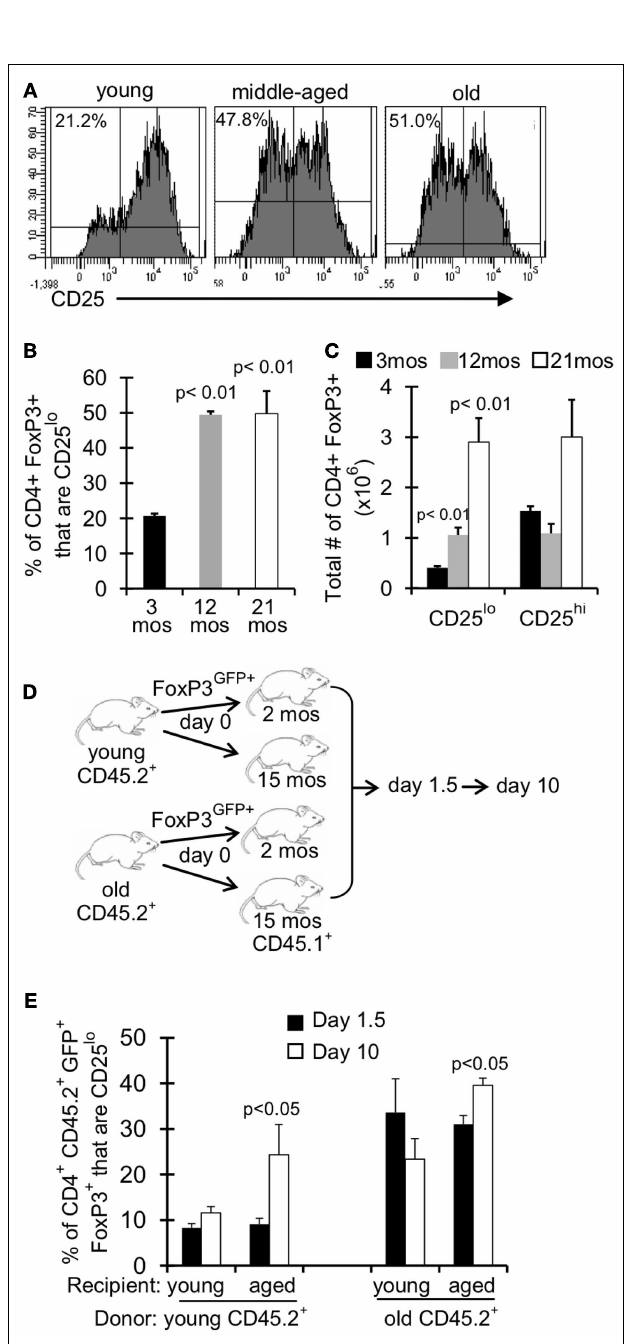
FIGURE 4 |An aged environment promotes emergence of CD25 lo T reg . (A–C) Splenocytes from young (3months; n = 4), middle-aged (12months; n = 4), and old (21months; n = 5) mice were stained for CD4, FoxP3, and CD25 and analyzed by flow. (A) Histograms show the expression of CD25 on CD4 + FoxP3 + cells. Percentages are the frequencies of CD4 + FoxP3 + that are CD25 lo . (B) Results show the frequency of CD4 + FoxP3 + cells that are CD25 lo ( ± SE).The p values represent the difference compared to 3-month-old mice (Student’s t test). (C) Results show the total number of CD4 + FoxP3 + cells that are CD25 lo or CD25 hi .The p values represent the difference compared to 3-month-old mice (Student’s t test). Results are representative of at least three independent experiments. (D,E) CD4 + FoxP3 GFP + T cells were sorted from splenocytes of young (3–4months)